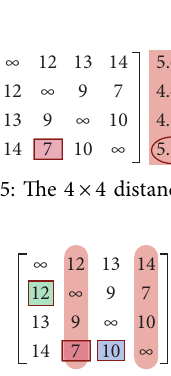
Figure 4: The 4 × 4 distance matrix.